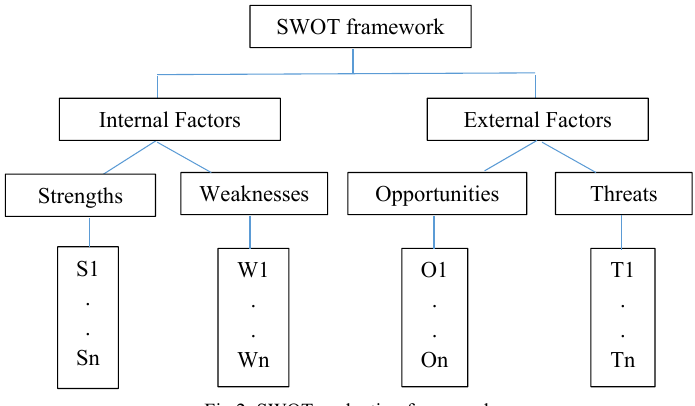
Fig 2: SWOT evaluation framework